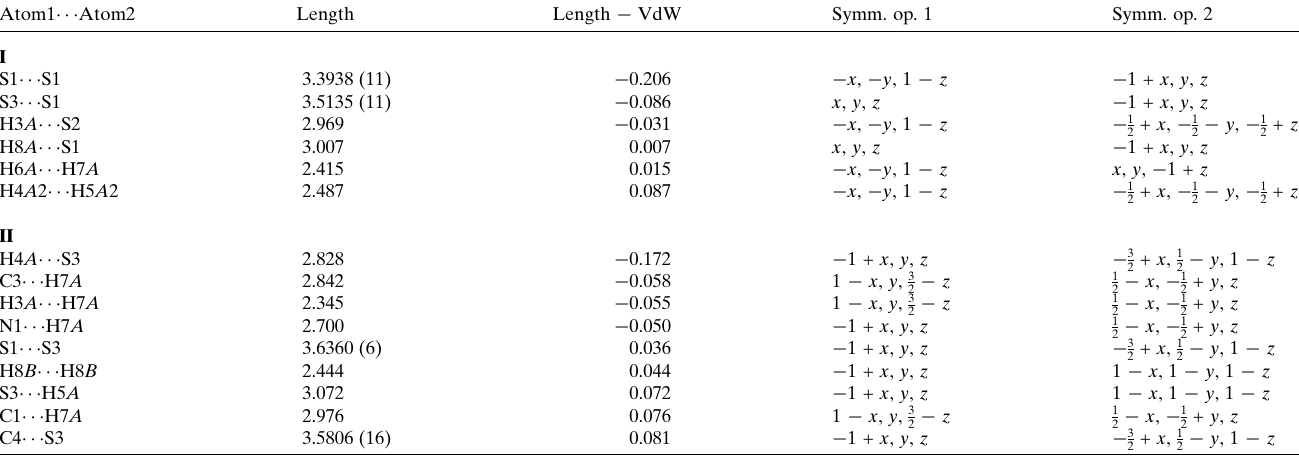
Table 3 Table 3. Short interatomic contacts a (A˚ ) for I ( m -bis L1) and II ( p -bis L1). Atom1 (cid:2)(cid:2)(cid:2) Atom2 Length